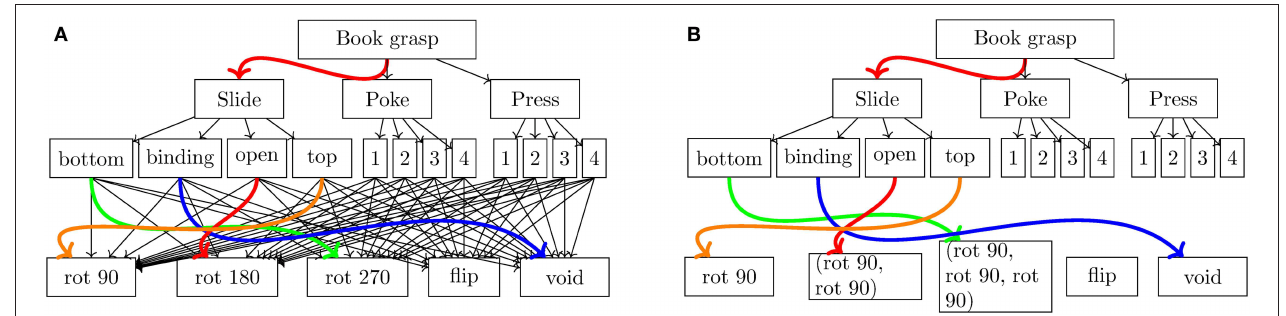
FIGURE 6 | Comparison of the results on a book grasping task between the original approach by Hangl et al. (2016) (A) and the novel extension presented in this work (B) . (A) Resulting ECM after training with the original approach by Hangl et al. (2016) on a book grasping task. All required preparatory behaviors have to be available at the beginning of the training process. As the training is only done model-free, training converges slower (c.f. section 11.3) and no preparatory behaviors can be generated when needed. The colored edges denote strong connections with high transition probabilities. (B) Exemplary resulting ECM of our novel approach on a book grasping task. At the beginning of the training process only the behaviors rotate 90 , flip and void were available. The behaviors shown in brackets were created using behavior composition. Note that due to the probabilistic nature of Equation (21) other behvaiors could be created like rotate 90, void, rotate 90 . For the sake of readability, the weak connections were omitted.